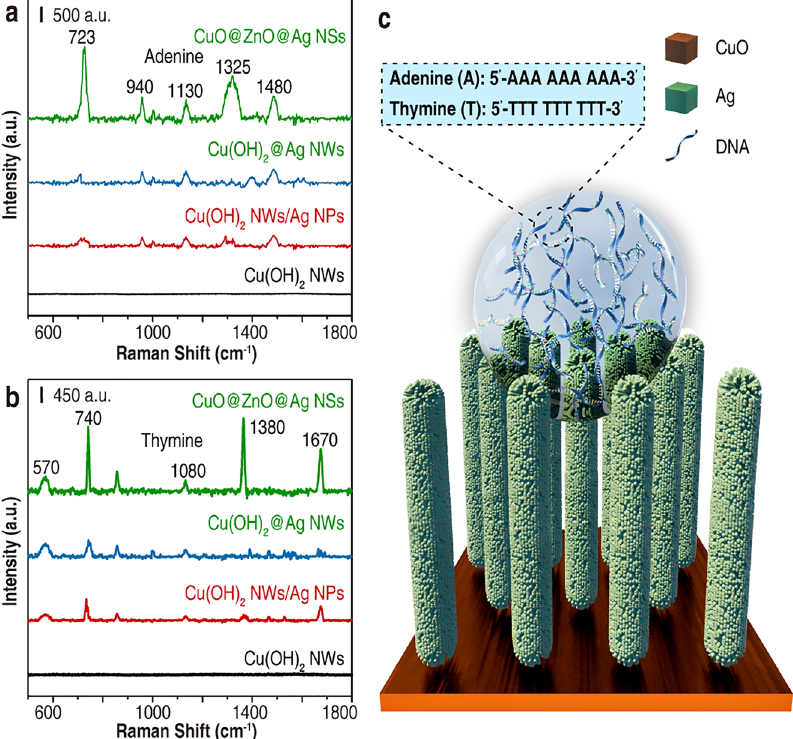
Figure 8: Raman spectra of (a) adenine and (b) thymine collected from different substrates, respectively; and (c)